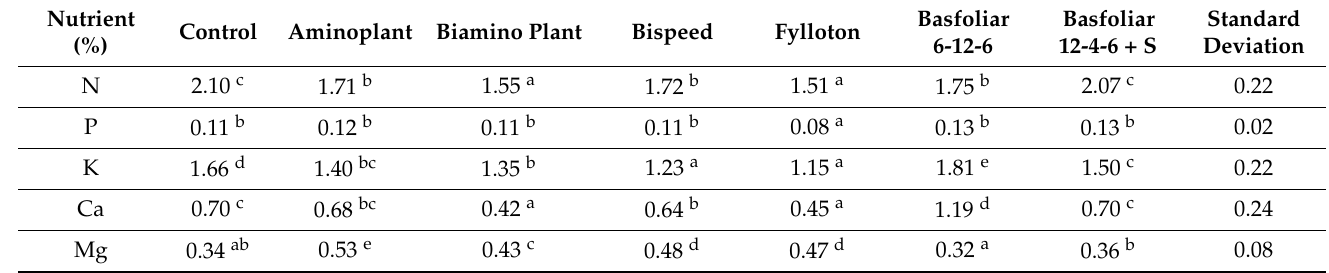
Table 8. Content of macronutrients in leaves of M.9 rootstock stoolings depending on the tested treatments.